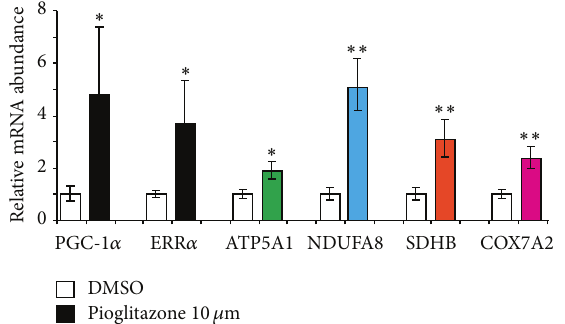
Figure 4: Endogenous PGC-1 𝛼 is a target for drugs designed to restore electron transport chain expression. Treatment with pioglitazone (concentration of 10 𝜇 M, 48 hours of treatment) perva- sively activated the PGC-1 𝛼 - ERR 𝛼 circuit. It induced a statistically significant 5-fold increase in expression of endogenous PGC-1 𝛼 , a significant 2-3-fold increase in endogenous ERR 𝛼 , and a resulting significant 2–5-fold- trans -activation of their endogenous electron transport chain target genes compared to cells treated with vehicle alone. Mean ± SEM shown ( 𝑁 = 10 for each treatment). ∗ denotes 𝑃 value ≤ 0.05. ∗∗ denotes 𝑃 value ≤